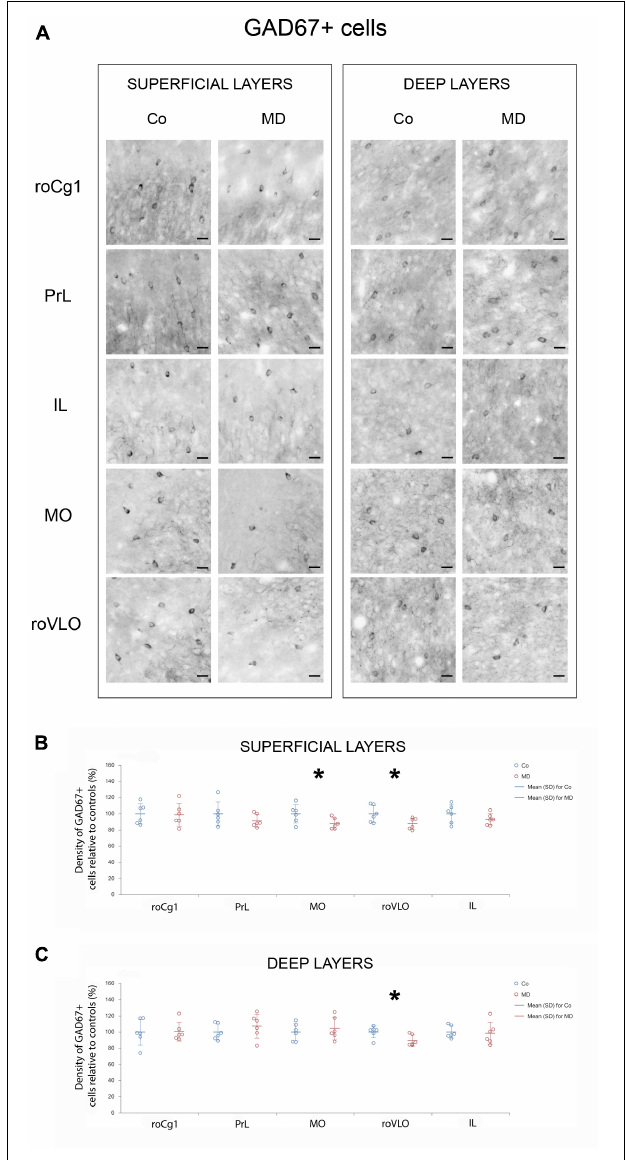
FIGURE 2 | Effects of MD on GAD67 + cell density in PFC on PND60. Representative photomicrographs of GAD67 + immunohistochemistry (A) . Dot plot graphs in (B,C) representing quantification of the results as means ± SD (horizontal bars) and observed values (dots), n = 6 per group in superficial and deep layers of the respective PFC area. MD rats had a lower density of GAD67 + cells in both superficial and deep layers of roVLO (B,C) as well as superficial layers of MO (B) . * p < 0.001 Co vs. MD. roCg1 rostral part of area 1 of cingulate cortex, Co control, IL infralimbic cortex, MD maternally